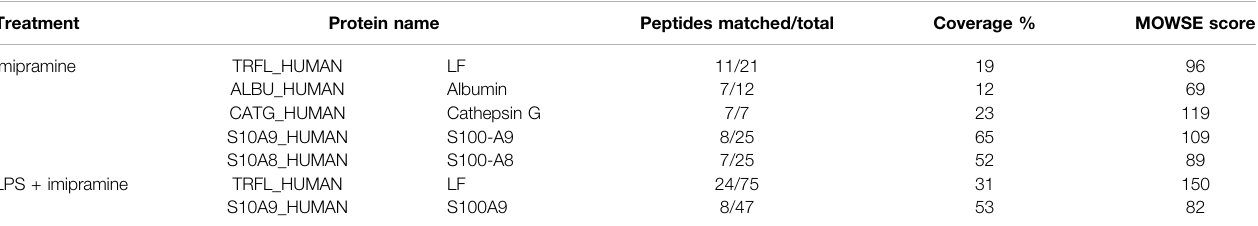
TABLE 1 | List of proteins secreted by control and LPS-stimulated neutrophils in adherence to fi bronectin in the presence of imipramine. Neutrophils were attached to fi bronectin for 25 min in the presence of 100 μ M imipramine or in the presence of 10 μ g/ml LPS plus 100 μ M imipramine. Proteins were separated by SDS-PAGE and